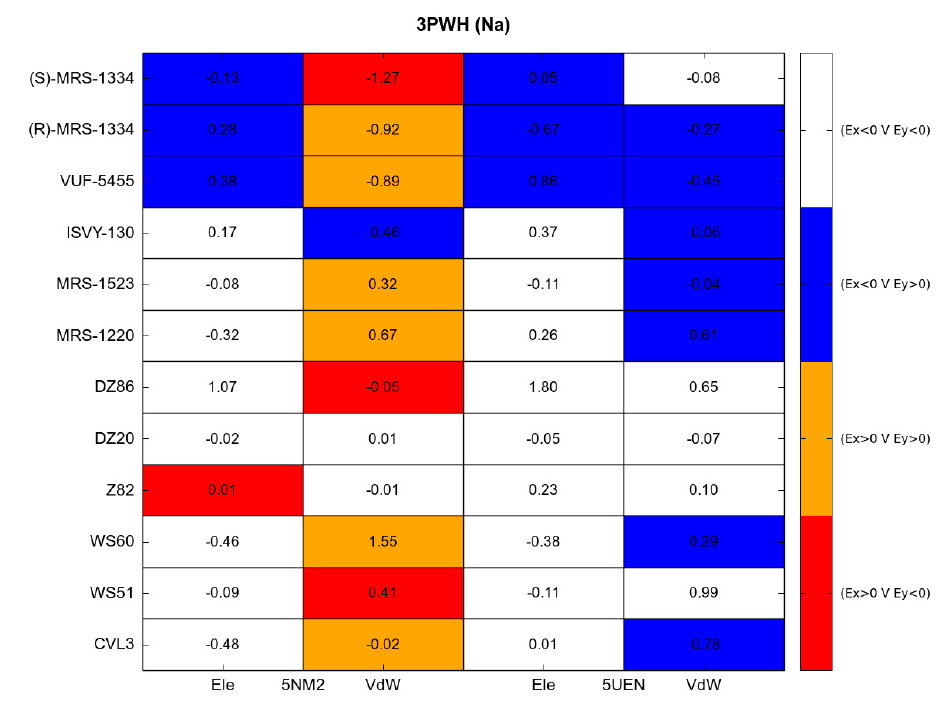
Figure 9. EM correlation matrix of energy contributions (electrostatic and van der Waals) for antagonists poses ( y -axis), obtained from the hA 2A -based model (5NM2) and the hA 1 -based model (5UEN), in comparison with the reference model (3PWH).